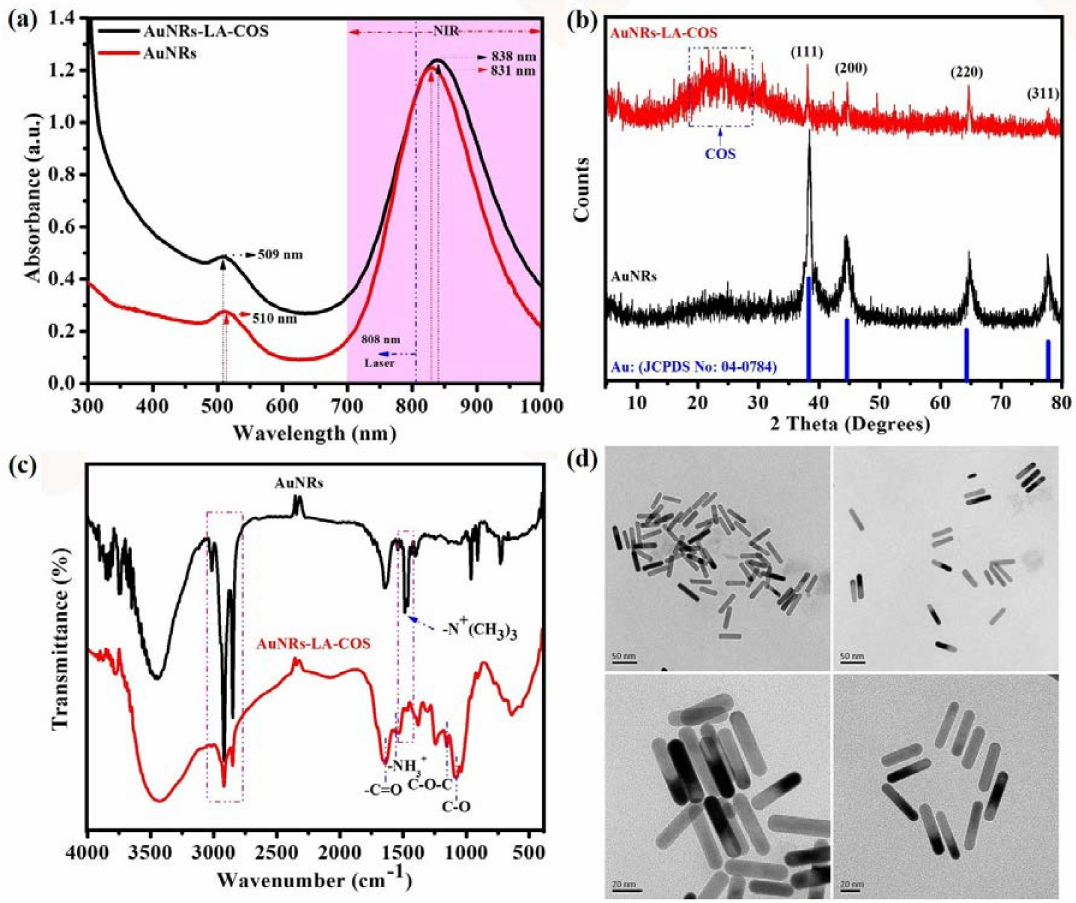
Figure 1. ( a ) UV-Vis-NIR absorbance spectra of AuNRs and AuNRs-LA-COS. ( b ) XRD patterns of AuNRs and AuNRs-LA-COS. ( c ) FTIR spectrum of AuNRs and AuNRs-LA-COS. ( d ) FETEM image of